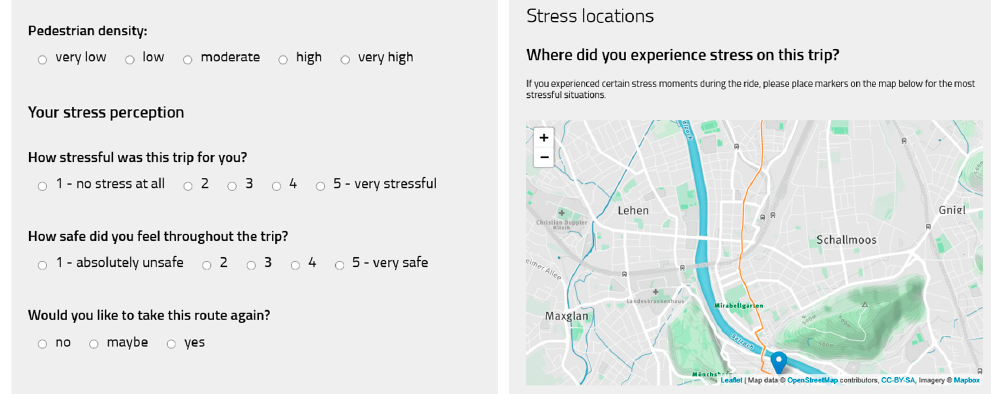
Figure 2. Excerpt of online trip-survey. An interactive web map was used to register individual stress locations that participants still remembered. locations that participants still